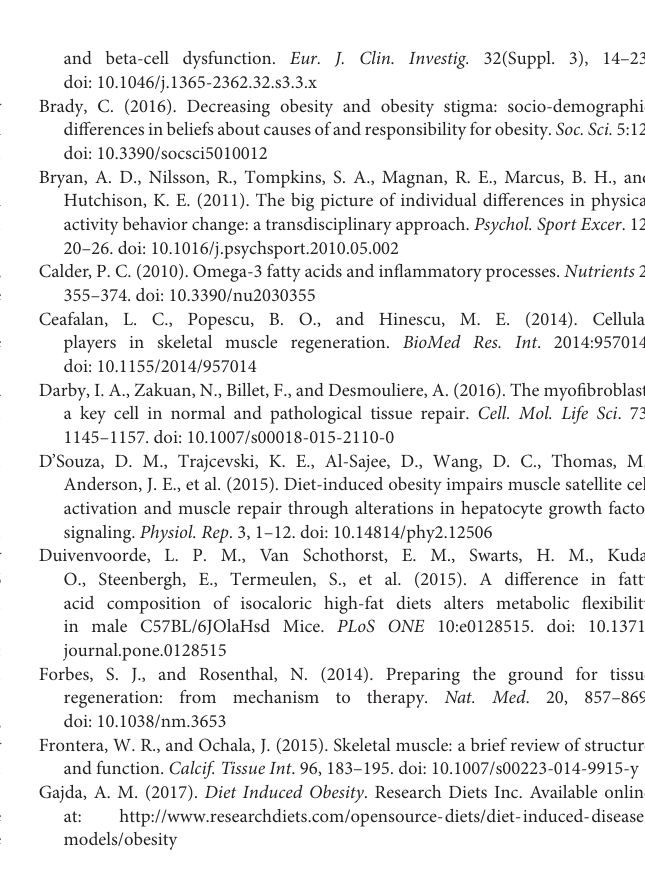
Supplementary Figure 1 | Fatty acid content in phospholipid fraction. Values are depicted as mean ± standard deviation.